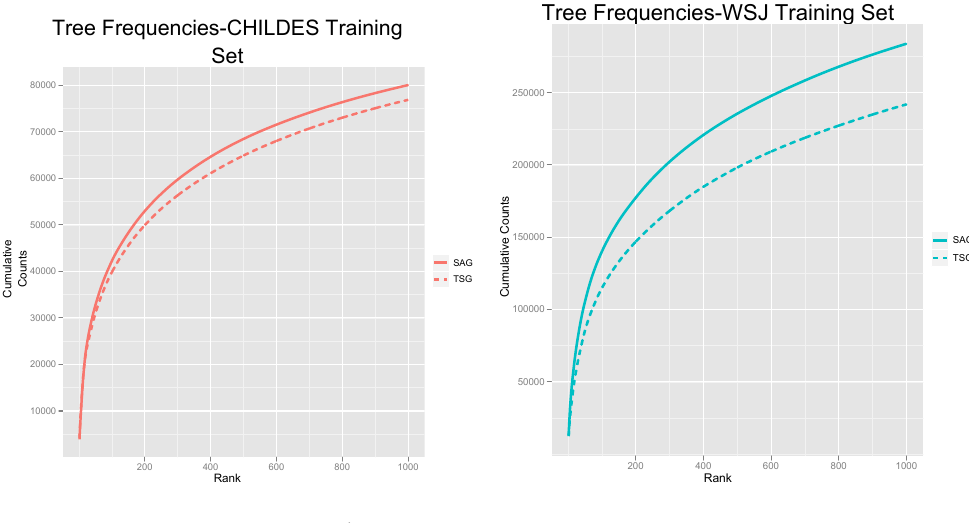
Figure 5: Cumulative